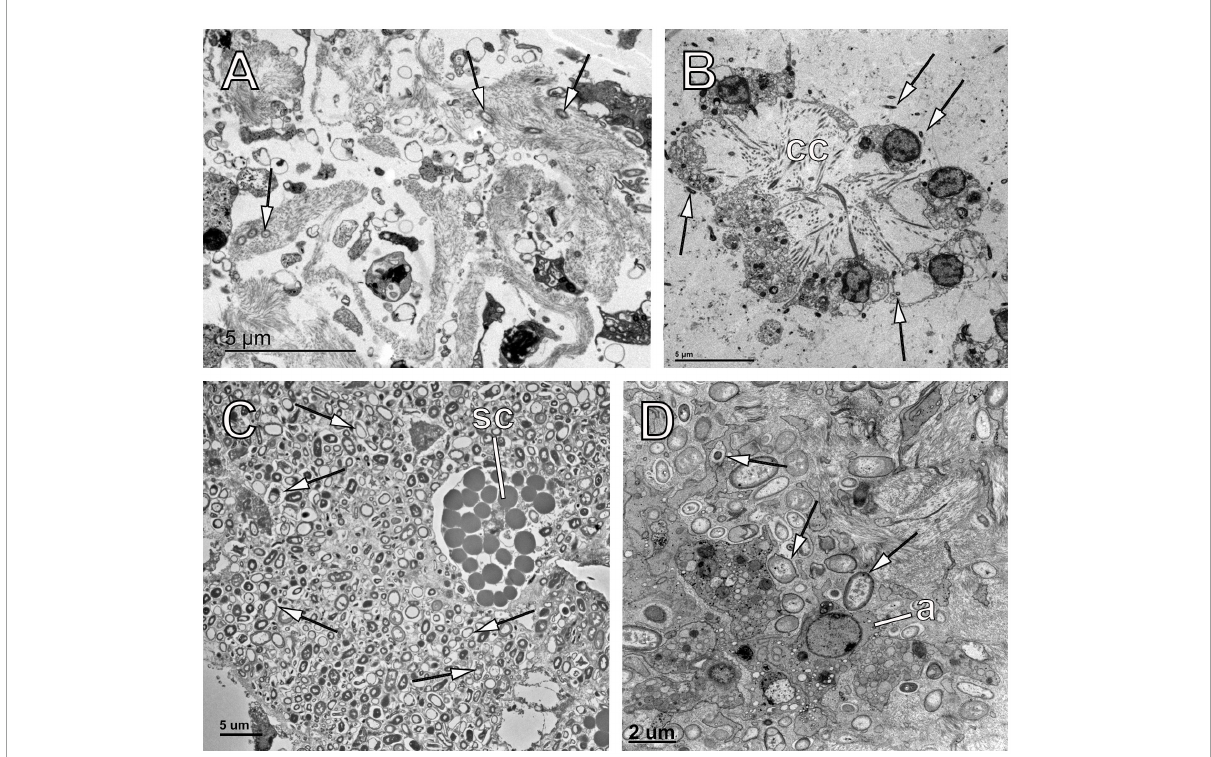
FIGURE1 Abundance of microbes in the mesohyl of sponges: HMA and LMA. (A) Mesohyl of the LMA haplosclerid sponge Hemigellius pilosus . (B) Mesohyl with a choanocyte chamber (cc) in the LMA axinellid sponge Raspaciona aculeata . (C) Mesohyl of the HMA tetractinellid sponge Geodia barretti showing a spherulous cell (sc). (D) Mesohyl of the HMA chondrosiid sponge Chondrosia reniformis showing an archaeocyte (a). Note the bacteria in all images